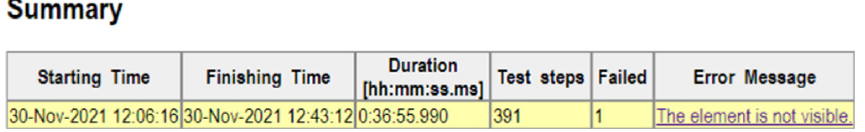
Fig. 5. A summary report of the test